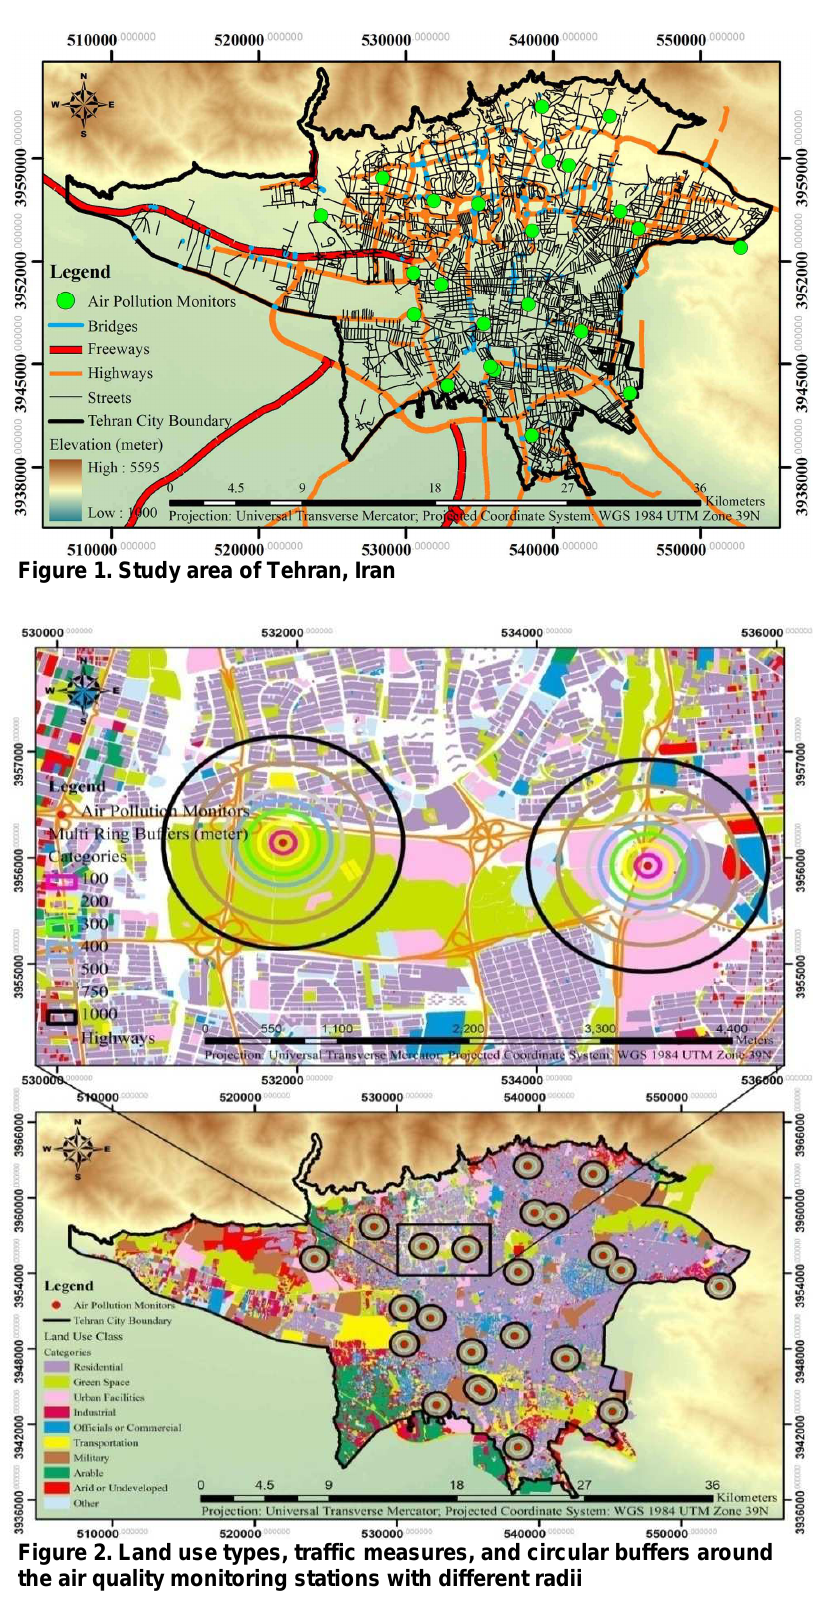
Figure 2. Land use types, traffic measures, and circular buffers around the air quality monitoring stations with different